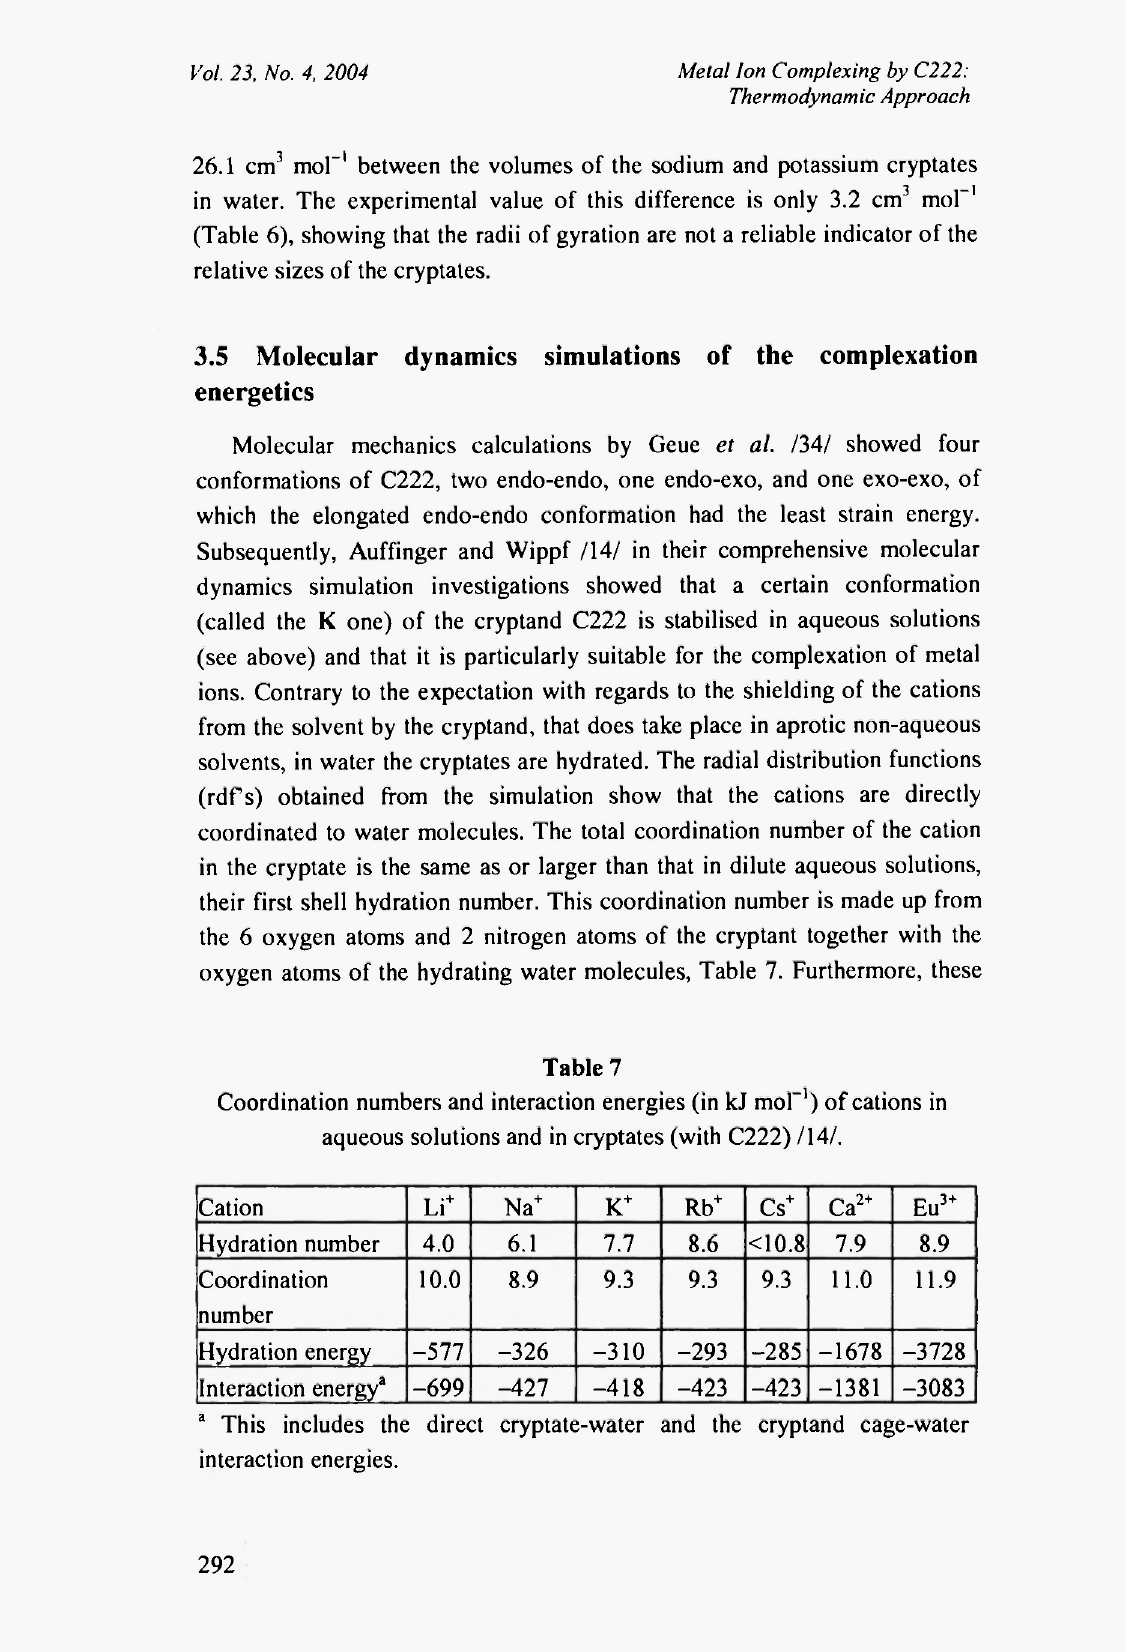
Coordination numbers and interaction energies (in kJ mol -1 ) of cations in aqueous solutions and in cryptates (with C222)